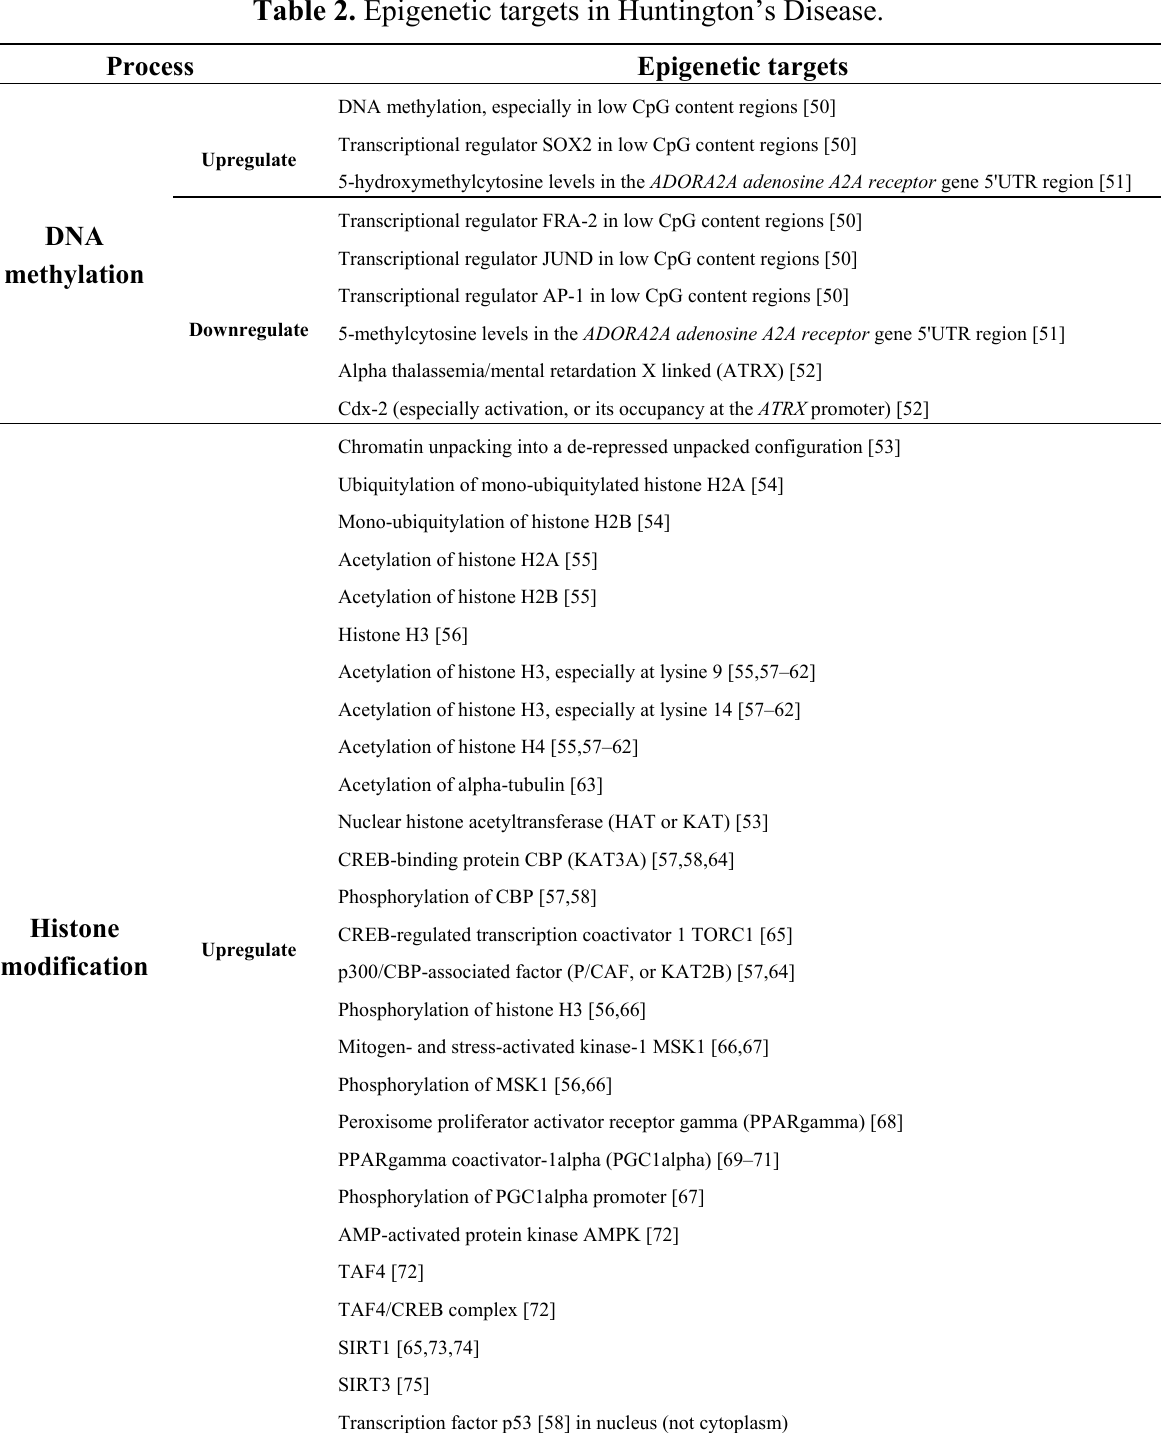
Table 2. Epigenetic targets in Huntington’s